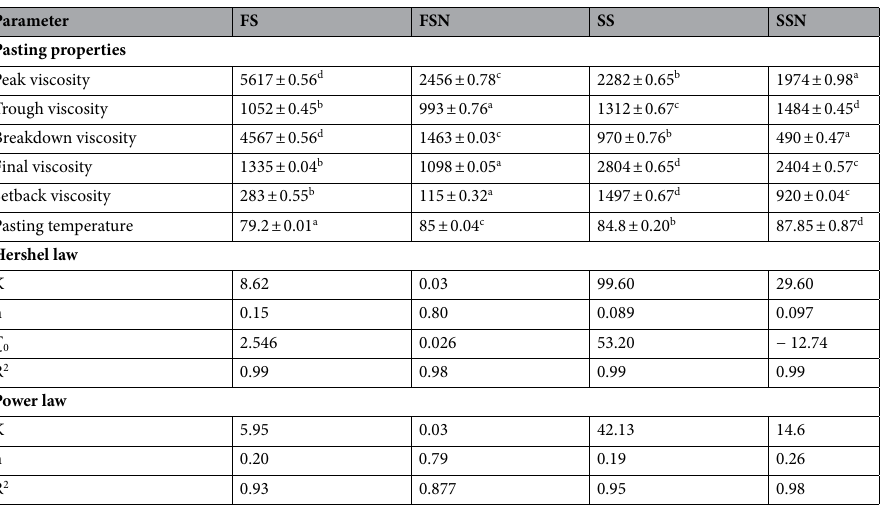
Table 4. Pasting properties and rheological parameters quantified by fitting the curve using Herschel–Bulkley equation and power law of native and nano starch samples. Ʈ 0 , K and n represents yield stress, consistency index, and flow behaviour index respectively. FS, FSN, SS and SSN represent native foxtail millet starch, nano foxtail millet starch, native sorghum starch and nano sorghum starch, respectively. Values expressed are mean ± standard deviation. Means in the row with different superscript (a, b, c & d) are significantly different at P ≥